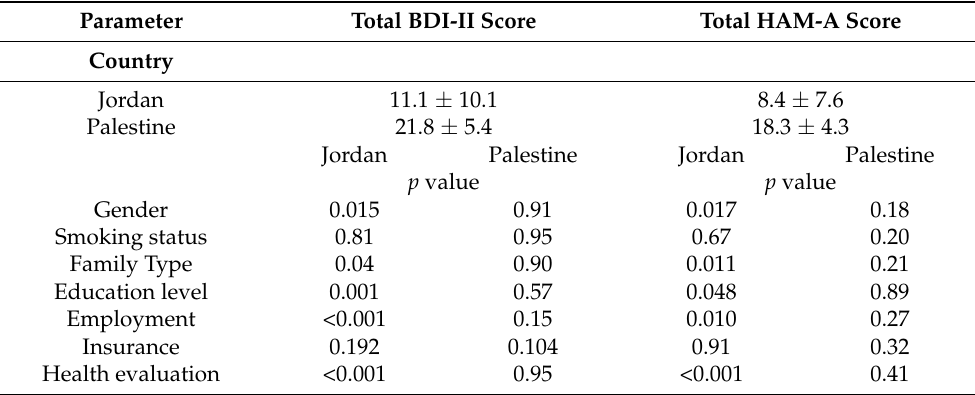
Table 3. Correlation between BDI-II and HAM-A scores and different participants’ categorical demographic variables ( N =